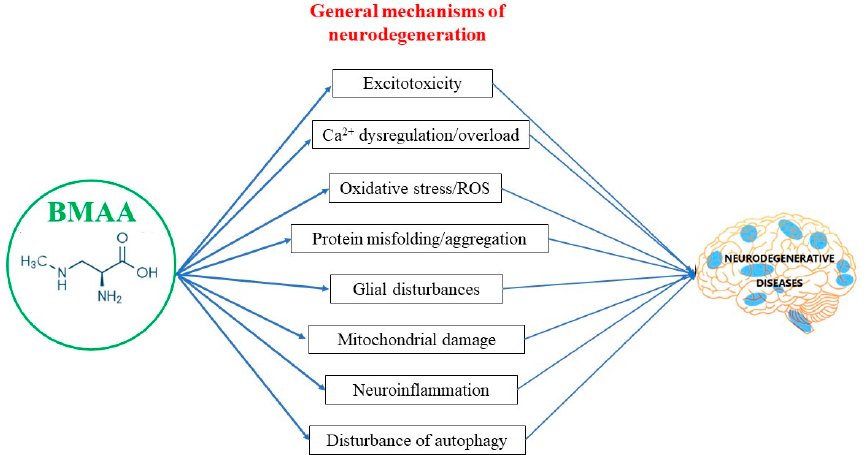
Figure 2. BMAA and general mechanisms of neurodegeneration.